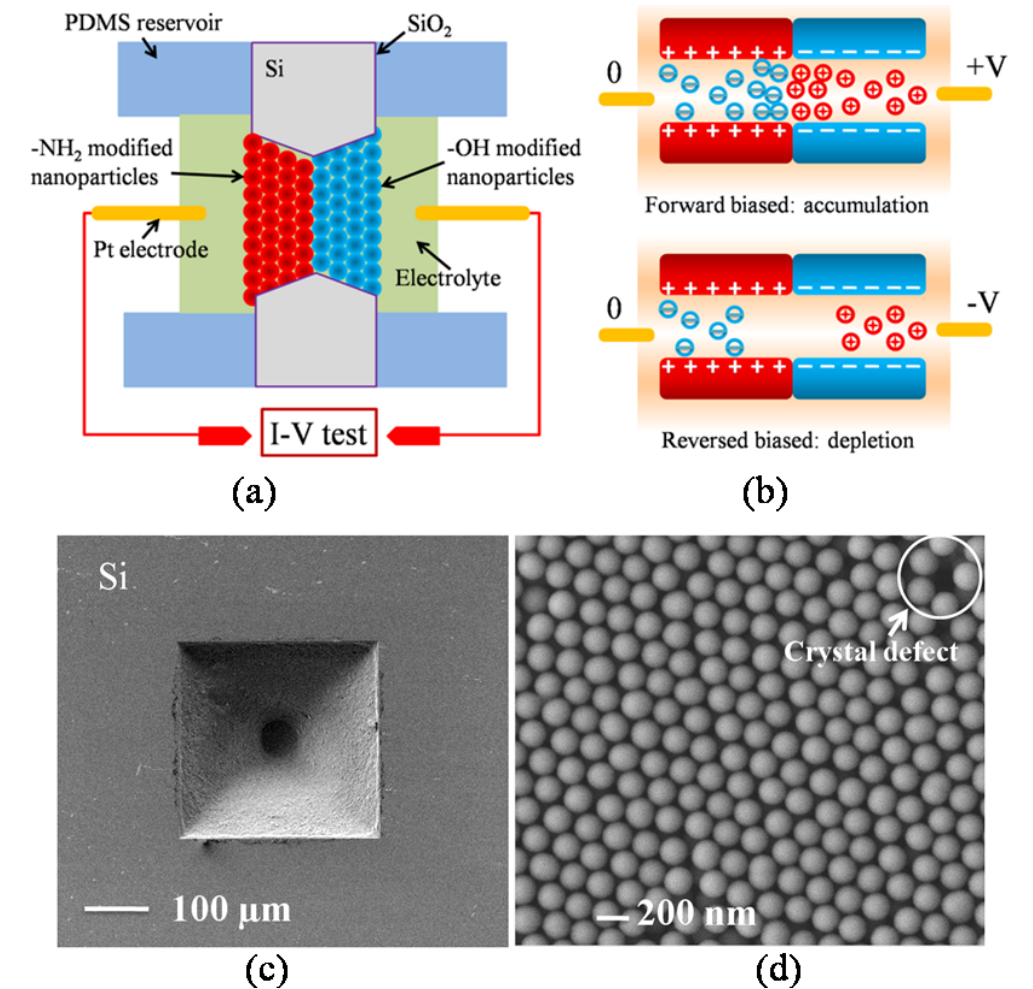
Figure 13. Nanofluidic diode in a suspended silica nanoparticle crystal (S-NPC). Schematic illustrations of the present S-NPC nanofluidic diode ( a ) and its working principle ( b ). SEM images of a silicon micropore after assembly of the hydroxyl modified nanoparticles at one end ( c ), and a magnified view of the nanoparticles at the interface before the second set of nanoparticles were packed ( d ). (Reprinted with permission from [107]. Copyright 2010, American Institute of